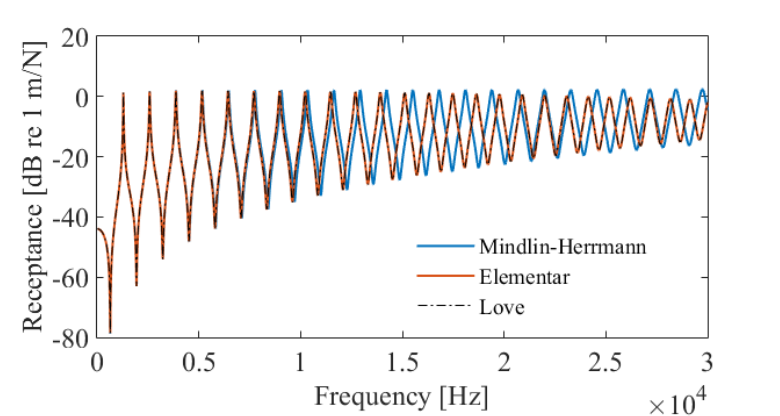
Figure 7. Comparison of the elementary, Love, and Mindlin-Herrmann rod